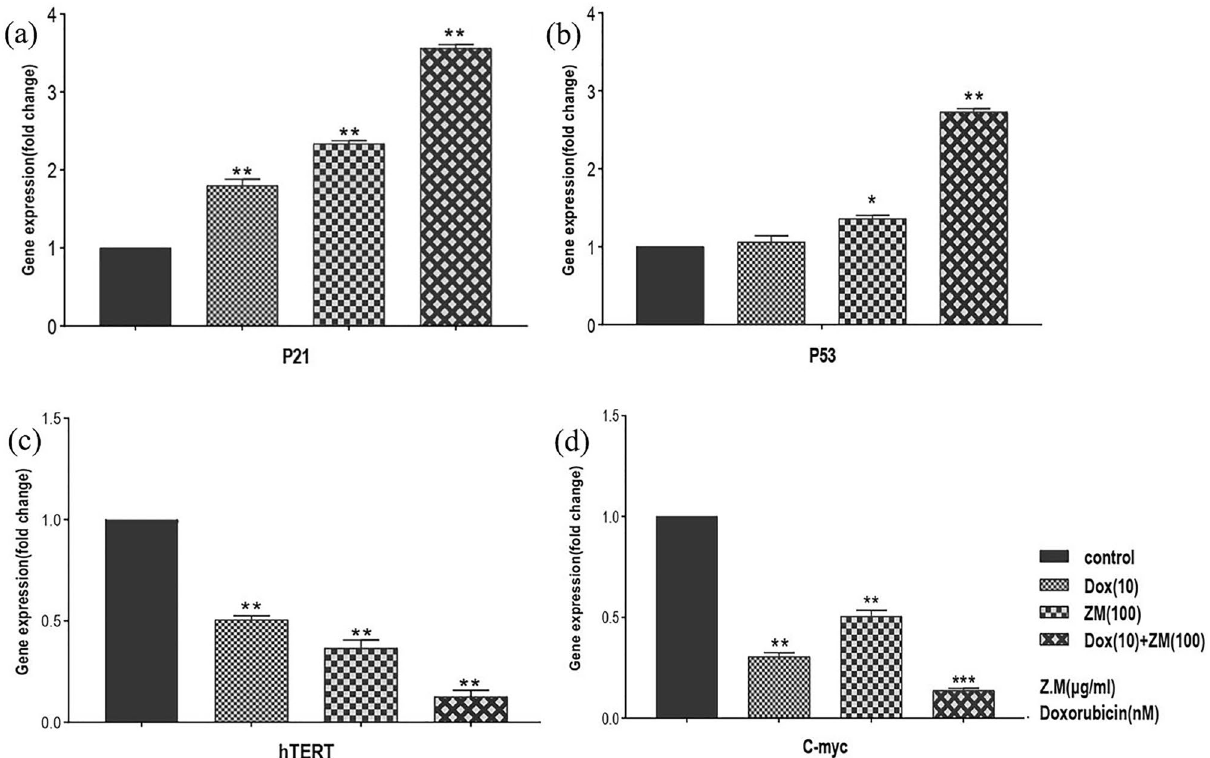
Figure 5. Gene expression graph presents that ZME and DOX down-regulates the h-TERT gene and c-Myc gene. A combination dose of ZME and DOX changes gene expression more than single doses on Nalm-6 cells after 48 h treatment. Fold change gene expression graph presents that ZME and DOX up-regulate P21 gene and P53 gene.